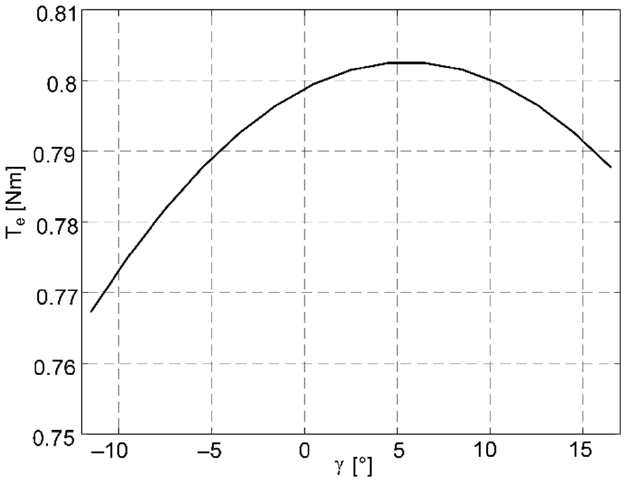
Figure 3. Change of torque with different excitation angles at nominal current. Table 3. Motor parameters at nominal speed, at nominal (I n ) and maximum current (I max ). Parameter I n I max Excitation (line) current RMS